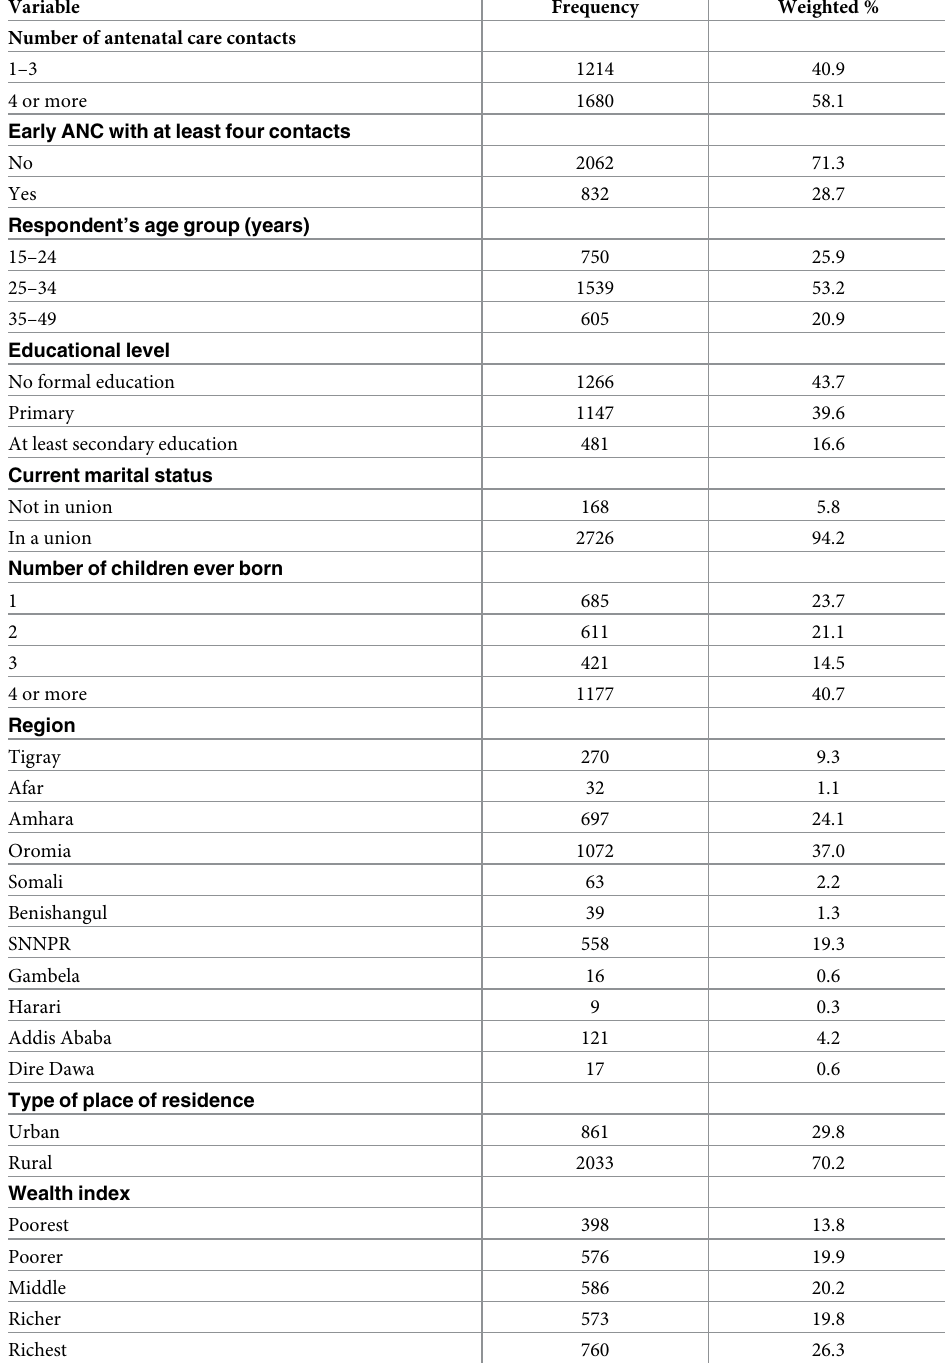
Table 1. Background characteristics of the women analysed (N =